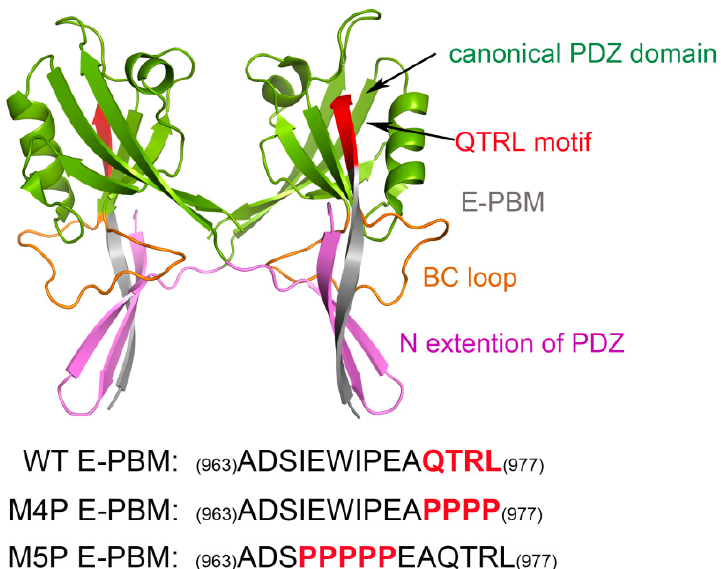
Figure 1. Shank 3-SAPAP modeling system. Protein is shown in ribbon model and the domains are colored according to the text in the map. The sequences of wild type E-PBM and mutated peptides are listed on the bottom.